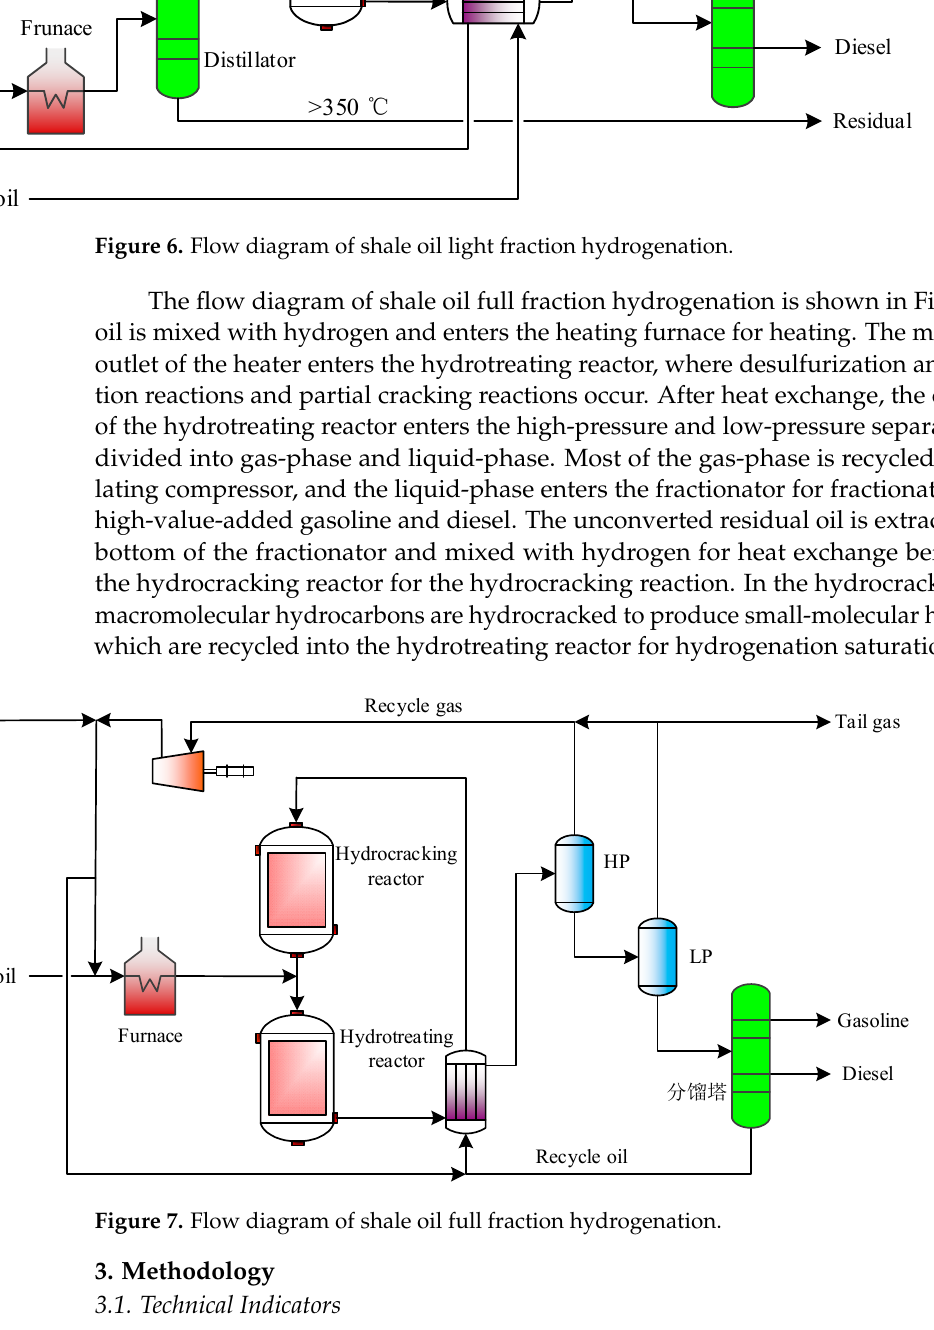
Figure 7. Flow diagram of shale oil full fraction hydrogenation.